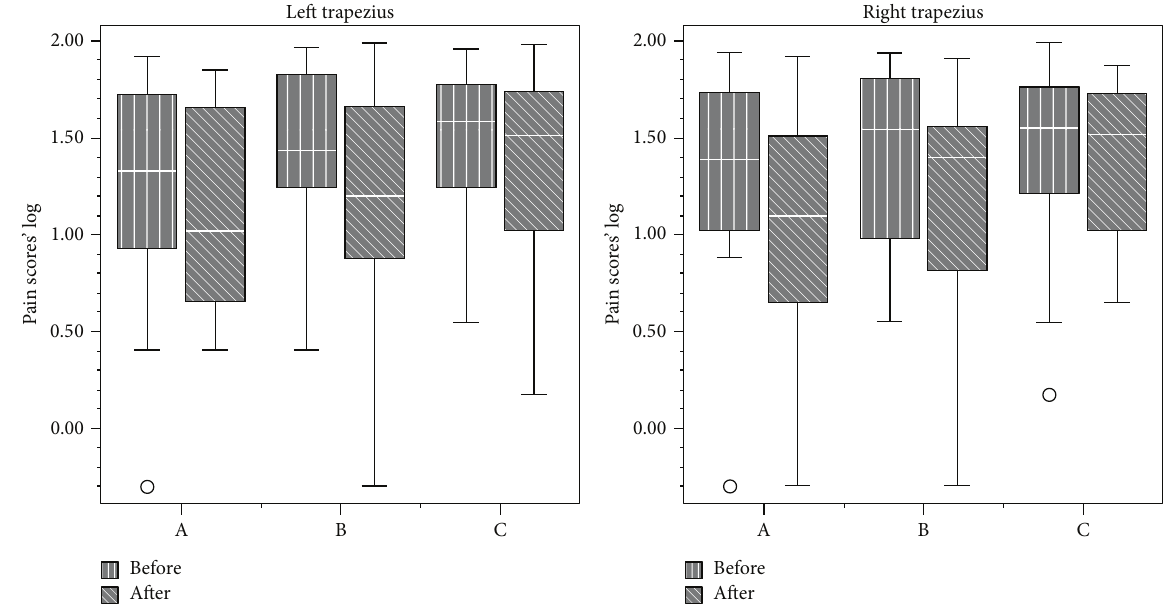
Figure2:Painscores(medianandinterquartileintervals)beforeandaftertreatmentinthetrapeziusmusclefromgroupsA(NSAID—sodium diclofenac), B (panacea—sodium diclofenac + carisoprodol + acetaminophen + caffeine), and C (placebo).